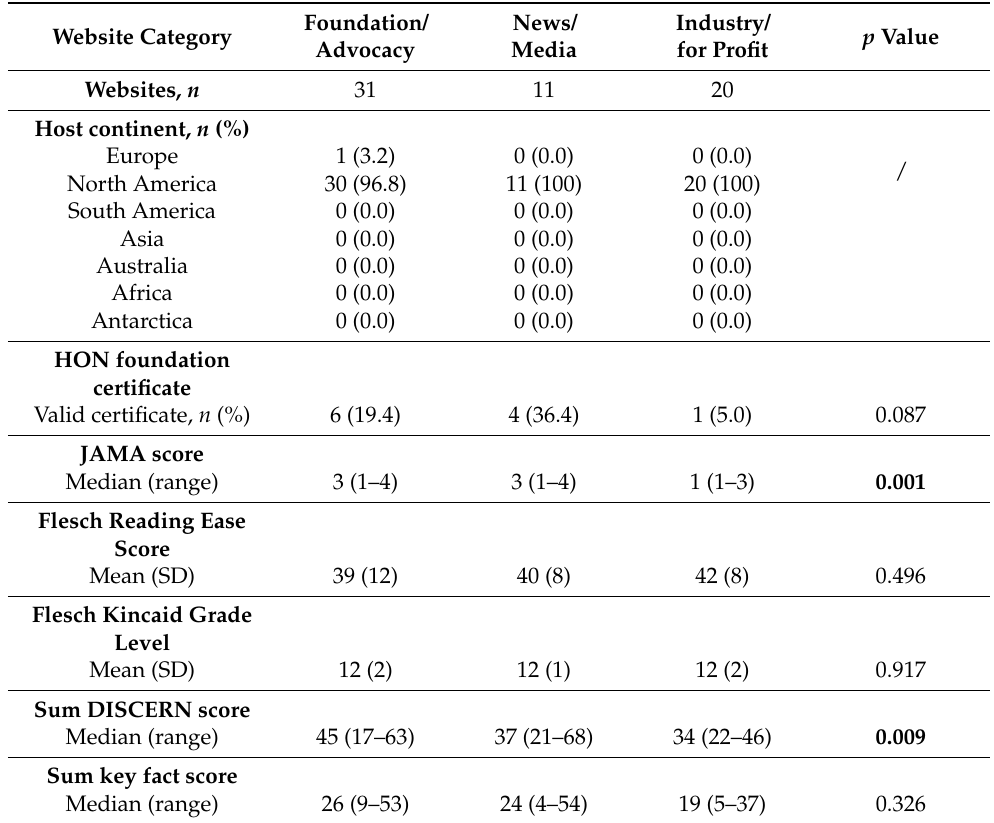
Table 2. Characterization of websites by